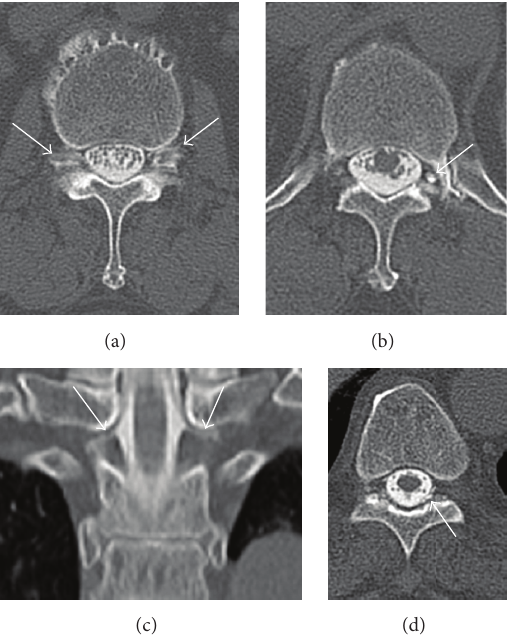
Figure 1: Computed tomography (CT) myelograms showing spontaneous spinal cerebrospinal fluid (CSF) leaks. (a) Bilateral CSF leaks ( arrows ) at L2-3 levels. (b) A contrast-filling nerve root sheath ( arrows ) at left T12-L1 level. (c) A coronal reconstruction image showing bilateral contrast-filling nerve root sheaths ( arrows ) at T1 level. (d) A small amount of contrast leak ( arrow ) in left T10 epidural